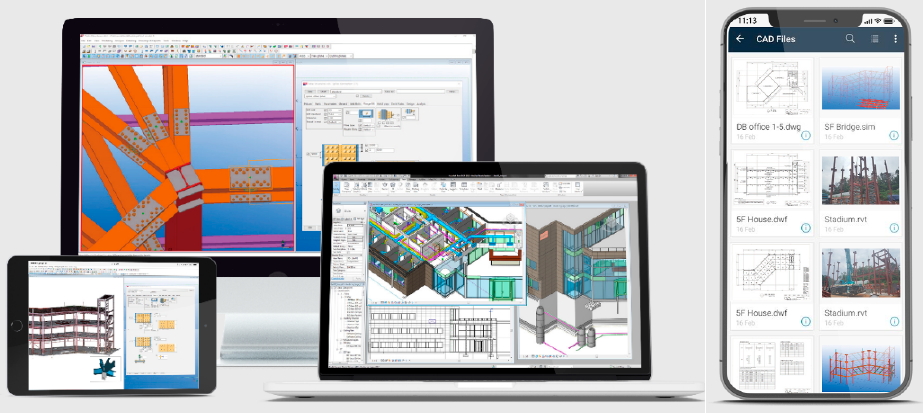
Figure 10. Web and app-based operational samples using the proposed system.